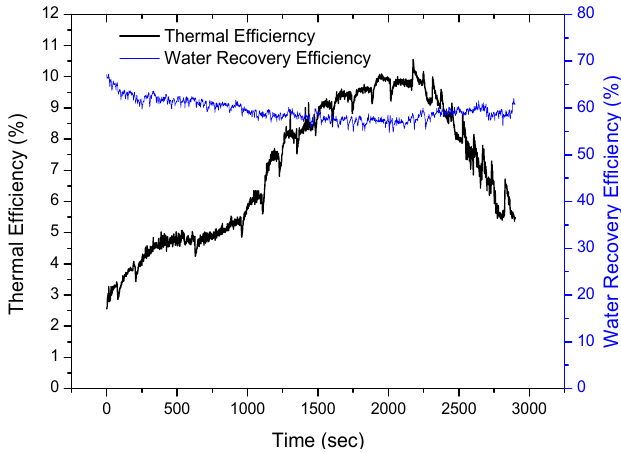
Figure 13. Thermal efficiency of ORC and water recovery efficiency.